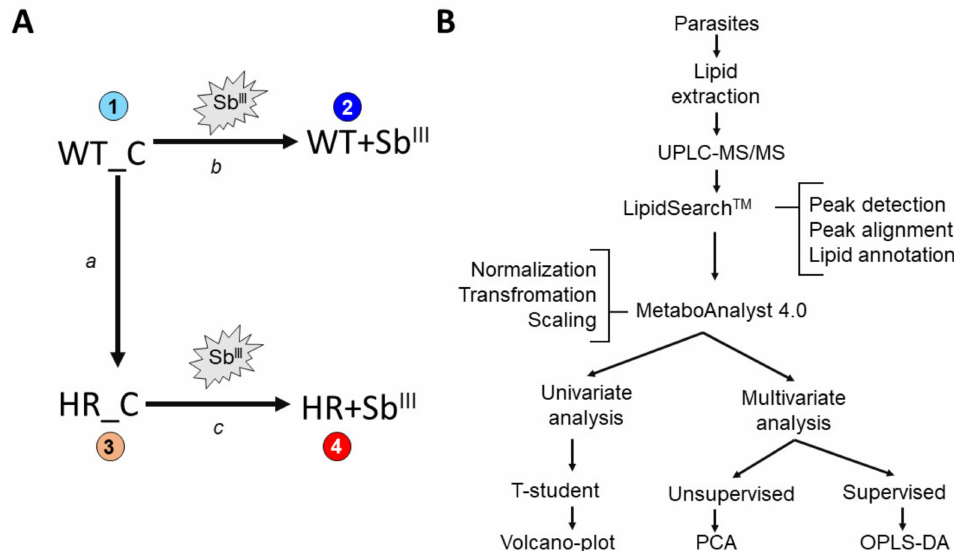
Figure 1. Schematic representation of the experimental design. ( A ) Four experimental conditions were evaluated (1–4), each one with three independent biological replicates. Experimental condition 1: Wild type strain control (WT_C), without Sb III pressure. Experimental condition 2: wild type strain growing under Sb III pressure (WT+Sb III ). Experimental condition 3: antimony highly resistant strain control (HR_C), without Sb III pressure. Experimental condition 4: antimony highly resistant strain growing under Sb III pressure (HR+Sb III ). Three dual comparisons for differential lipid expression were performed (a–c). (a) Basal changes in drug resistant strain in the absence of drug, by the comparison of resistant strain HR_C versus sensitive WT_C in the absence of Sb III drug. (b) Sensitive strain responding to Sb III by the comparison of WT+Sb III versus WT_C. (c) Highly resistant strain responding to Sb III by the comparison of HR+Sb III versus HR_C. ( B ) Summarized workflow for lipidomic analysis from lipid extraction to statistical analysis including the integration of the LipidSearchTM (Thermo Scientific) and metaboanalysit 4.0 software. Volcano plots were used for the differential lipid expression analysis at the univariate method while principal component analysis (PCA) and Orthogonal partial least squares discriminant analysis (OPLS-DA) for multivariate